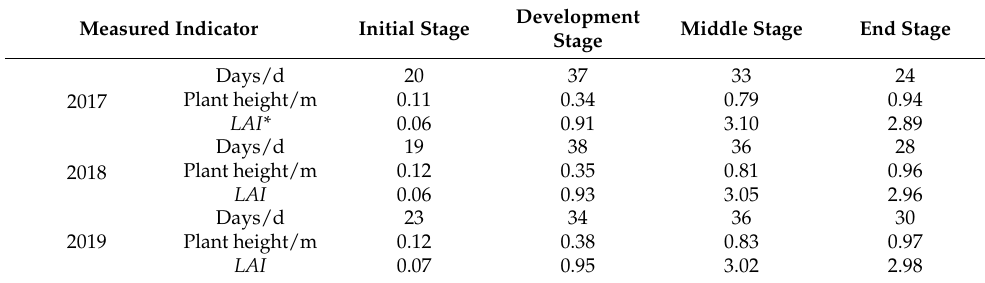
Table 1. Duration of the crop development stages and measured growth indicators of greenhouse- grown eggplant in the 2017–2019 growing